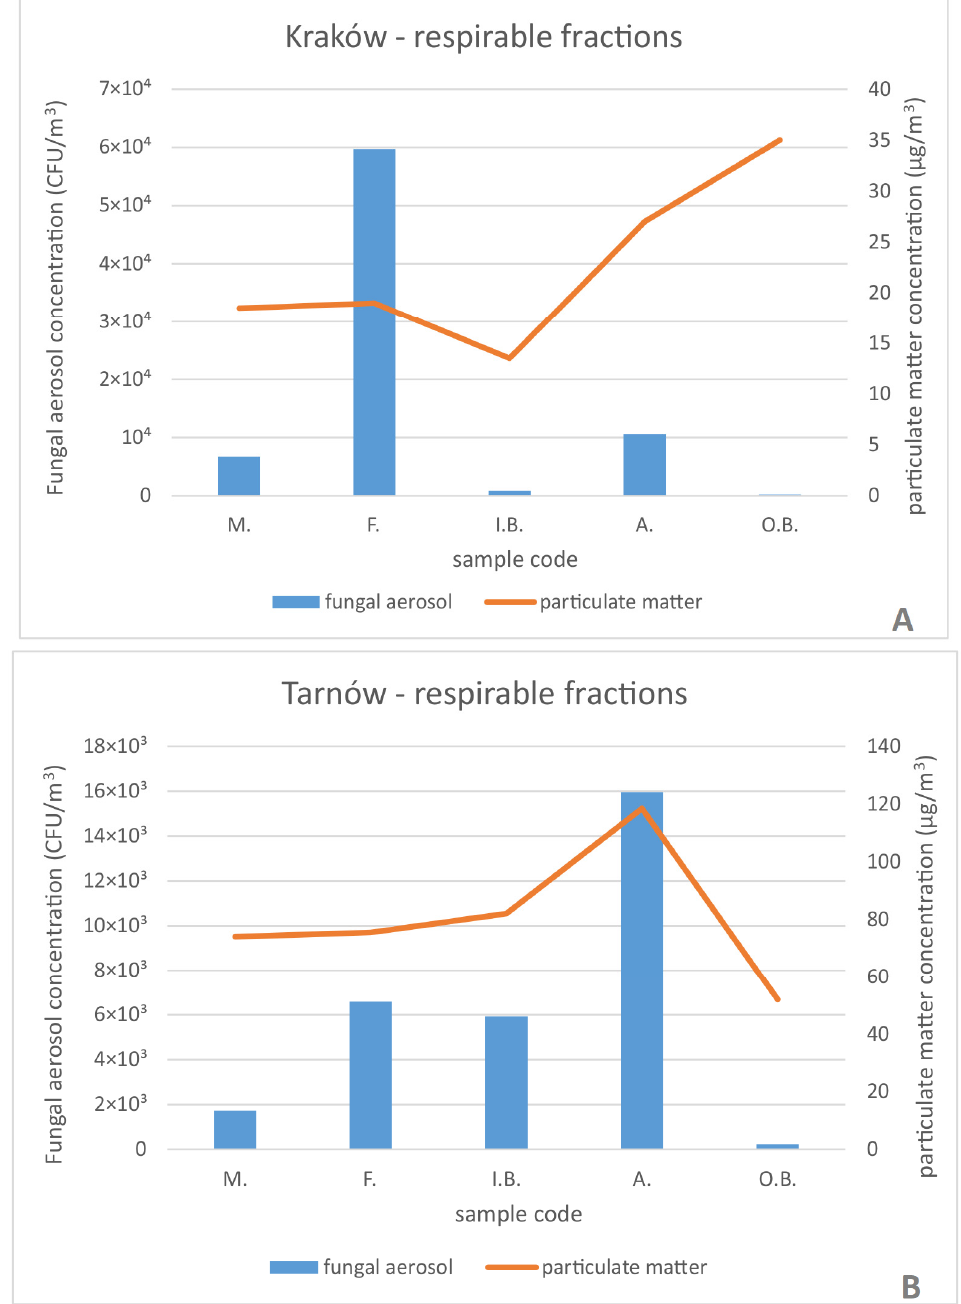
Figure 5. Concentration of respirable fungal aerosol (CFU/m 3 ) at different times of the day compared with the concentration of respirable particulate matter (µg/m 3 ). Kraków ( A ) and Tarnów ( B ) horse stables.